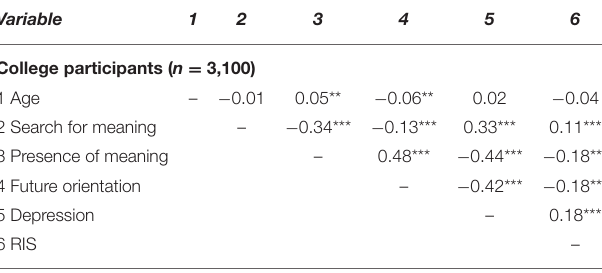
TABLE 2 | Pearson correlation matrix for continuous